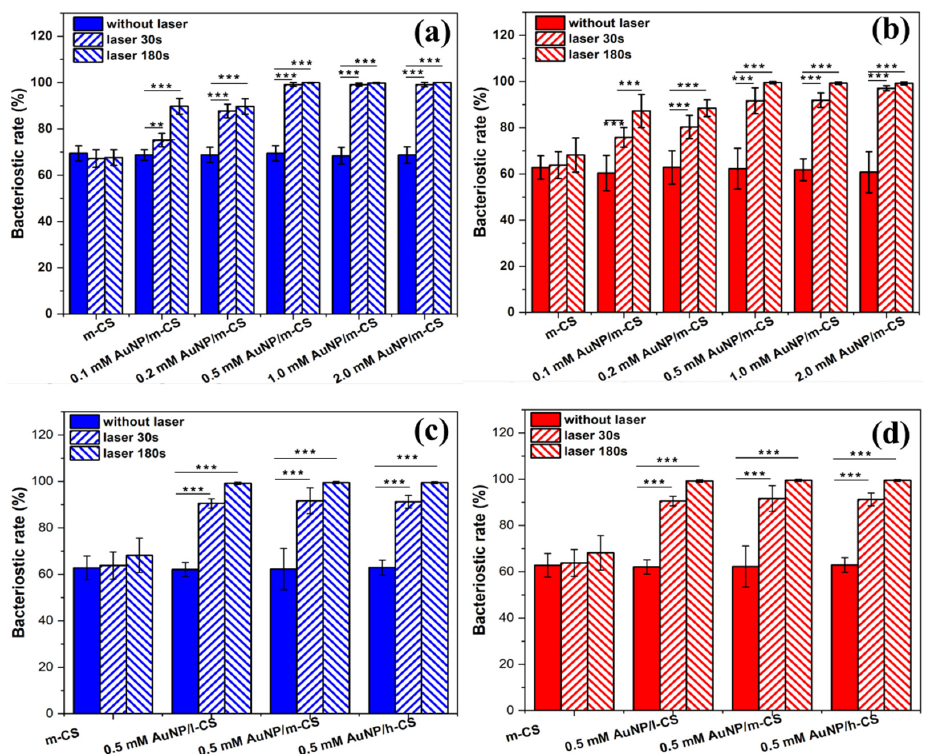
Figure 8. ( a , c ): Bacteriostatic rate of the samples against E. coli ; ( b , d ): Bacteriostatic rate of the samples against S. aureus , ** p < 0.01 and *** p < 0.001 vs corresponding group without laser.